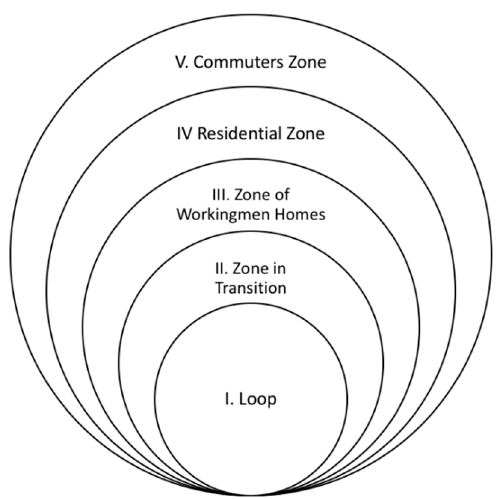
Figure 1. Burgess Model, “The Growth of the City.” Image recreated by the author.